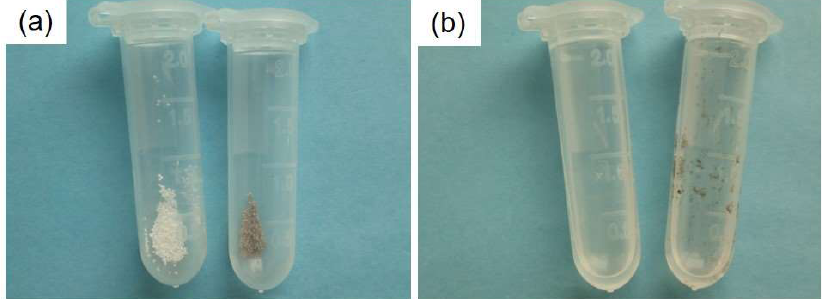
Figure 5. Corrosion of PLGA microspheres ( a ) and PLGA@PDA microspheres ( b ) in dichloromethane (DCM).